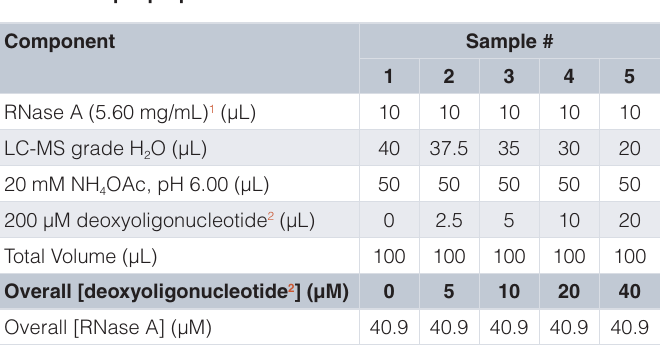
Table 1. Sample preparation.